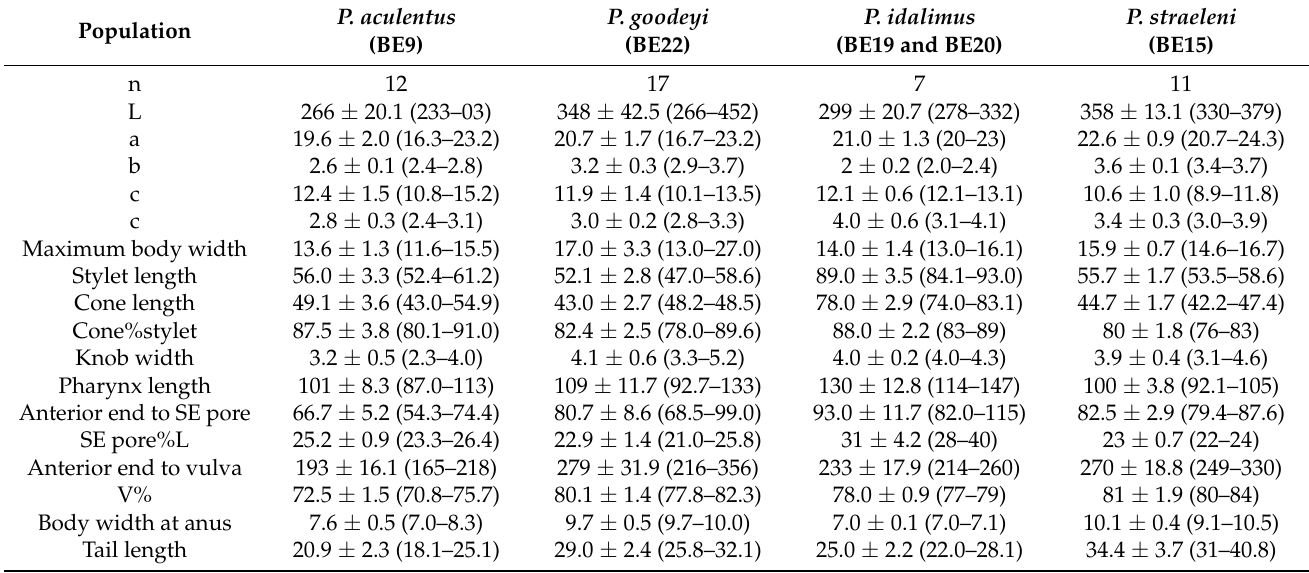
Table 2. Female morphometrics of Paratylenchus aculentus , Paratylenchus goodeyi , Paratylenchus idalimus and Paratylenchus straeleni from fixed specimens mounted in glycerine. All measurements except for ratios and percentages are given in µ m and in the form mean ± stdev